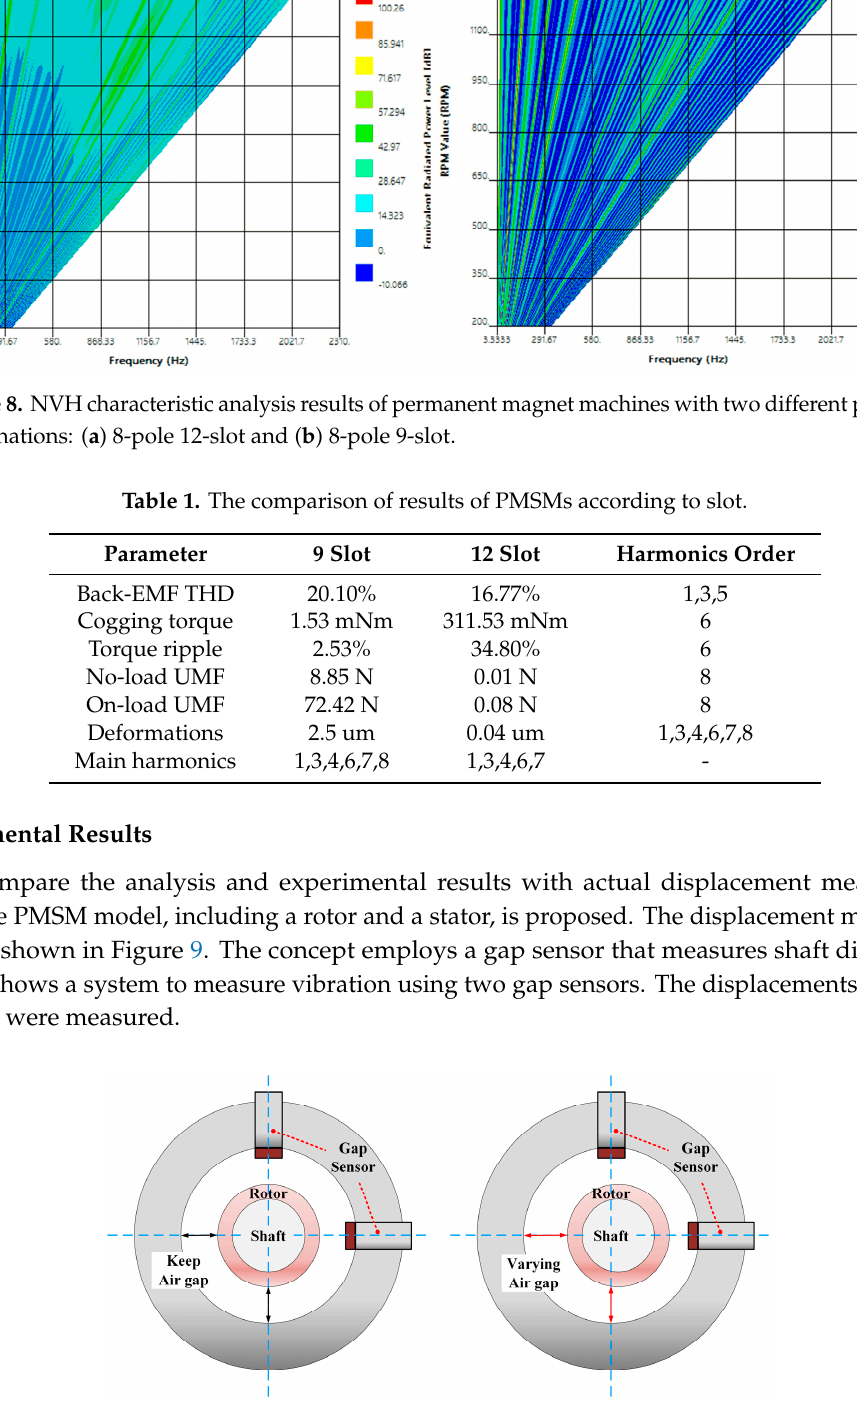
Figure 9. Schematic diagram of the displacement measurement concept. The experimental results were validated by comparing them with the measurement